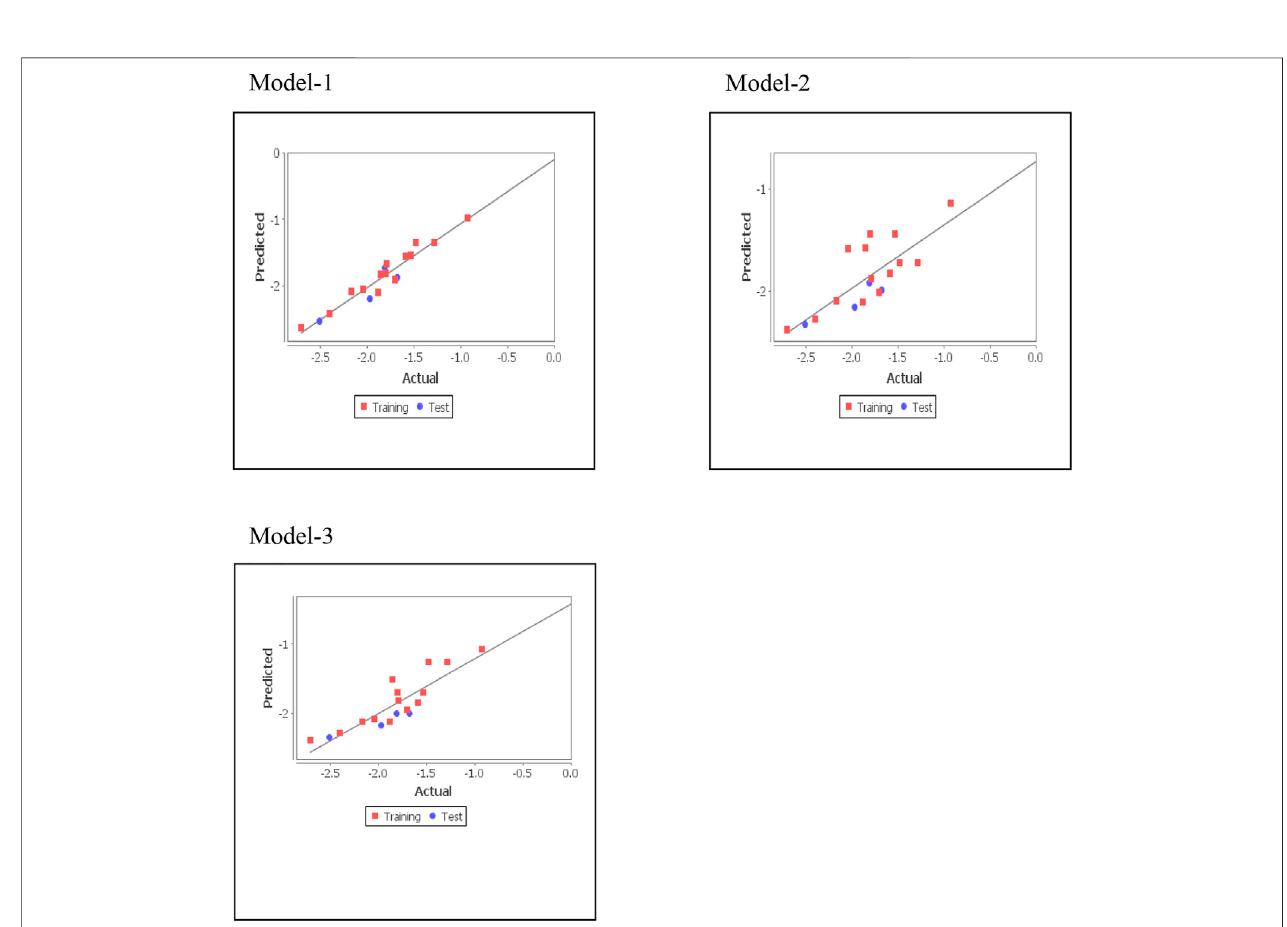
FIGURE 1 | Graphs of experimental vs. predicted fungicidal activity of different models.